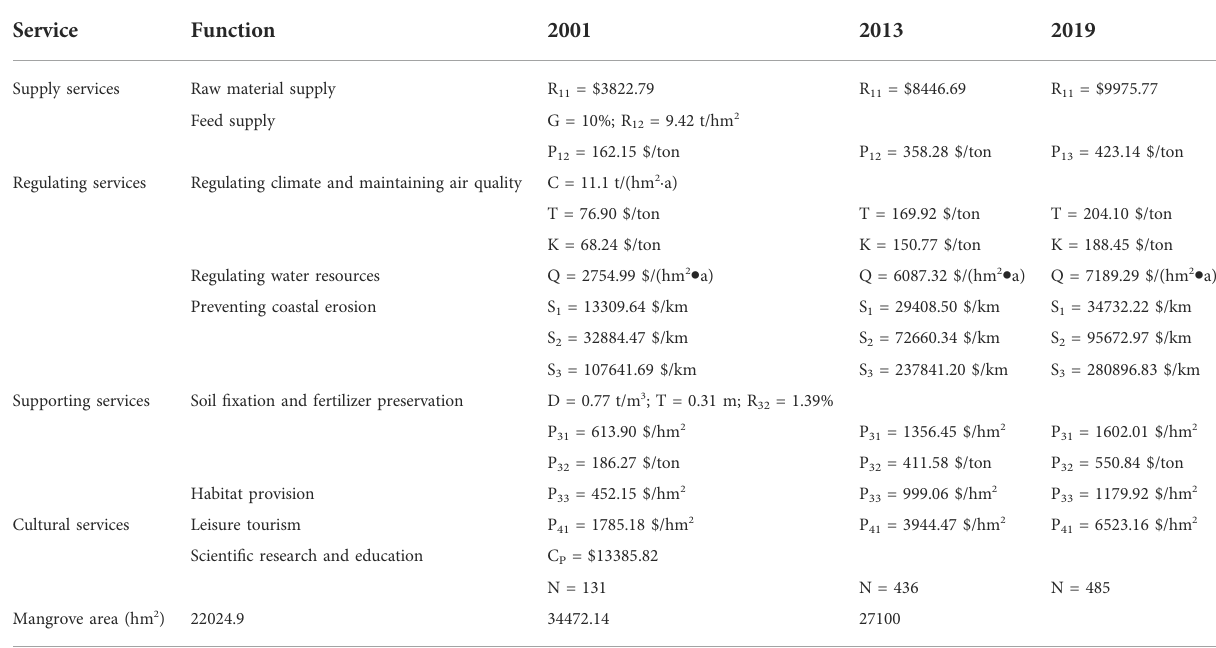
TABLE 2 The parameters selected for monetary valuation of mangroves in